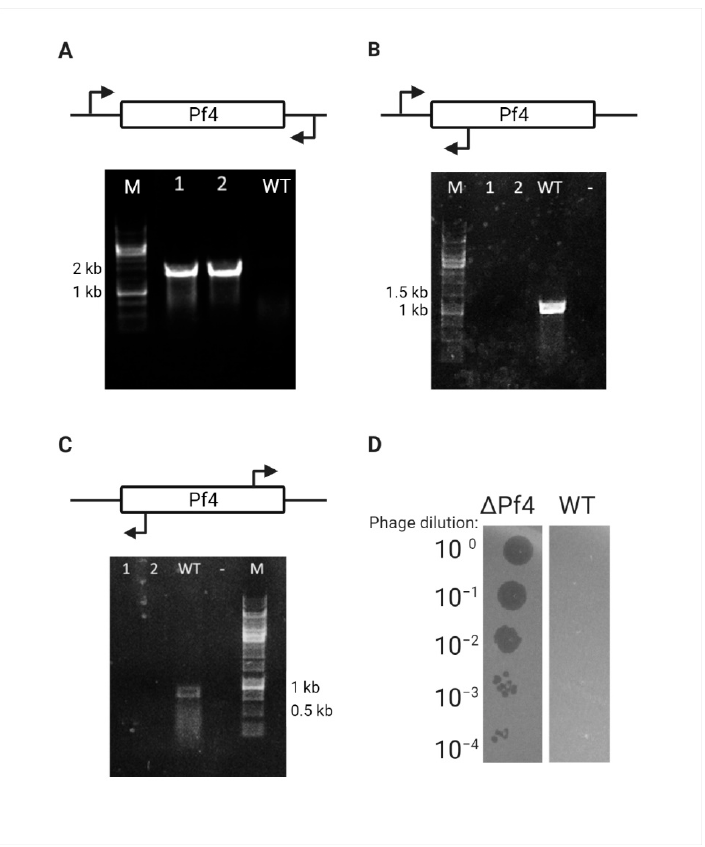
Figure 2. Pf4 curing verification. (A-C) Curing verification by PCR, Lanes 1–2 represent the DNA of randomly picked Crb-sensitive colonies, and lane 3 represents the WT PAO1 for control. ( A ) Amplification of 1800 bp around the Pf4 attB site. ( B ) Amplification of 1000 bp around the Pf4 attR site that can only be amplified in the integrated form. ( C ) Amplification of 750 bp around the Pf4 attP site that can only be amplified in the RF form. ( D ) Curing verification by plaque assay, serial dilutions of Pf4 phage are extracted from WT PAO1 strain used to infect WT PAO1 and ∆ Pf4 strain.